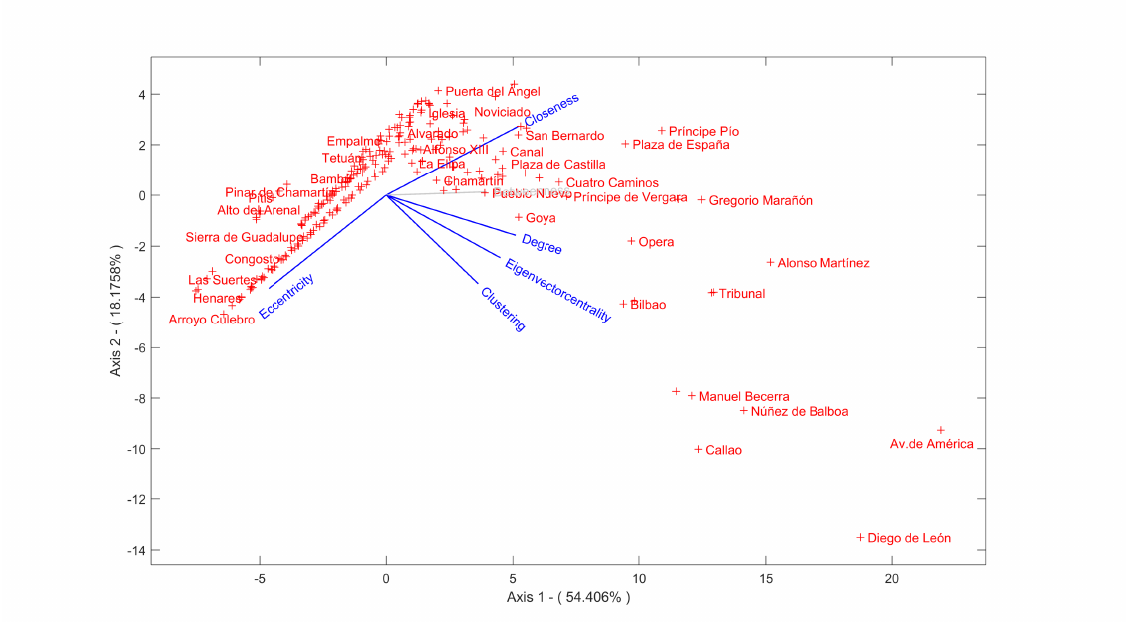
Figure 5. HJ Biplot representation on the main first